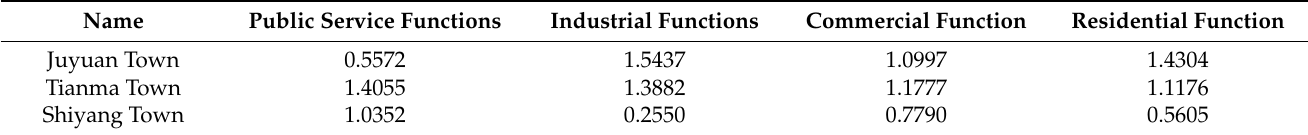
Table 5. Locational entropy values of each functional element.